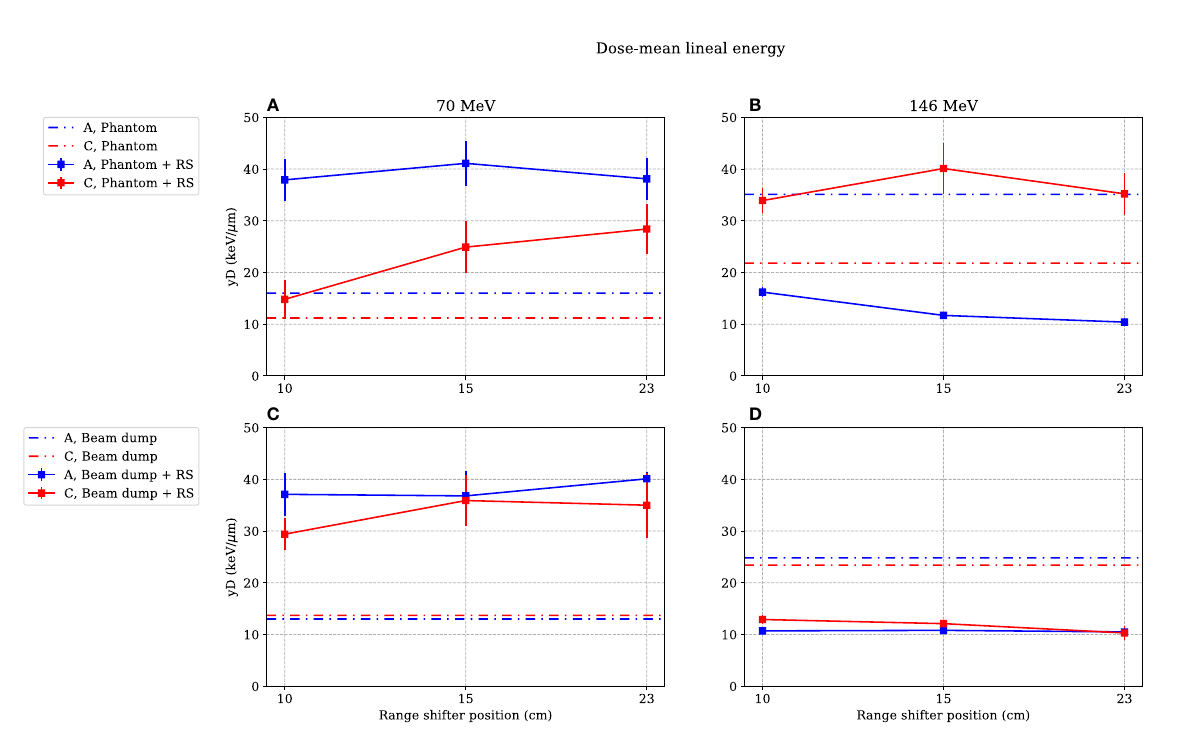
FIGURE 5 Dose-mean lineal energies as functions of range-shifter positions when irradiating the phantom (A, B) and the proton beam dump (C, D) . The range-shifter positions correspond to the air gaps when the phantom was present. Irradiating with 70-MeV protons, the range shifter leads to a higher (cid:1) y D value at both positions A and C, while with 146 MeV, the (cid:1) y D value measured at position A is lower and decreases with increased range-shifter position with the presence of a phantom (B) . When irradiating the beam dump with 146-MeV protons, the (cid:1) y D values decrease both at position A and position C (D) The lines between data points are used as guide for the eye. The dashed – dotted lines show the levels without range shifter, i.e., scattered from the phantom or from the beam dump. As mentioned in Section 3.4, the values are illustrated with statistical uncertainties only with k =